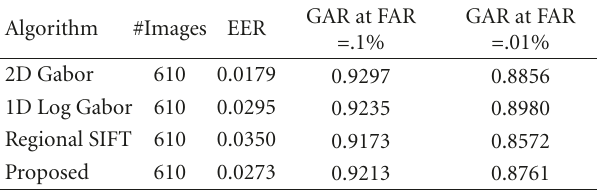
Table 2: IUPUI remote database frontal look eyes matching results. Table 3: Recognition results of the regional SIFT method for same eyes divided into classes based on angle of